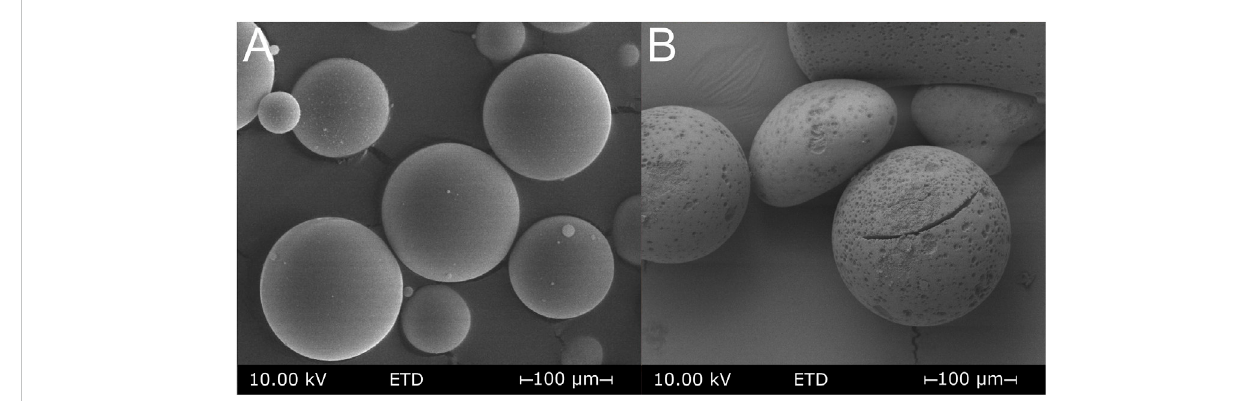
FIGURE 1 Electro-microscopic image of the silica spheres before (A) and after (B) the leaching procedure to create porosity.